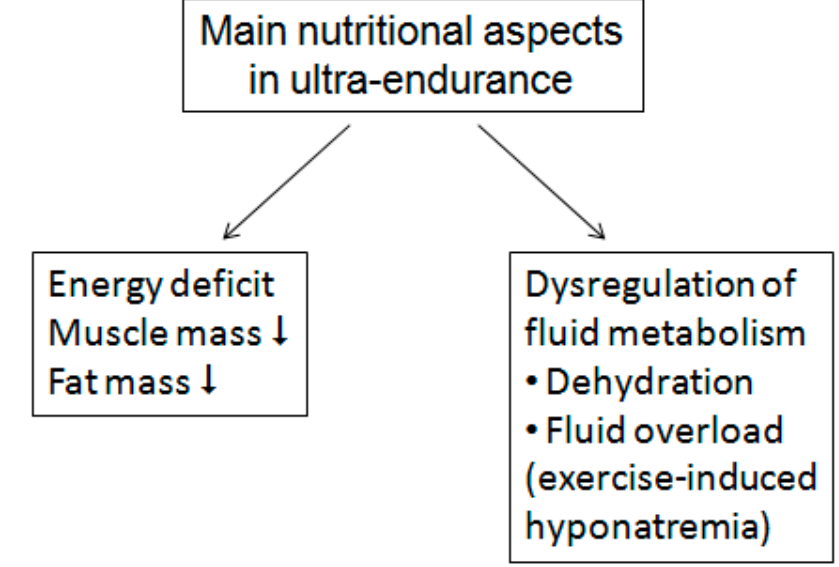
Figure 1. Main nutritional aspects in ultra-endurance. ↓ = decrease.